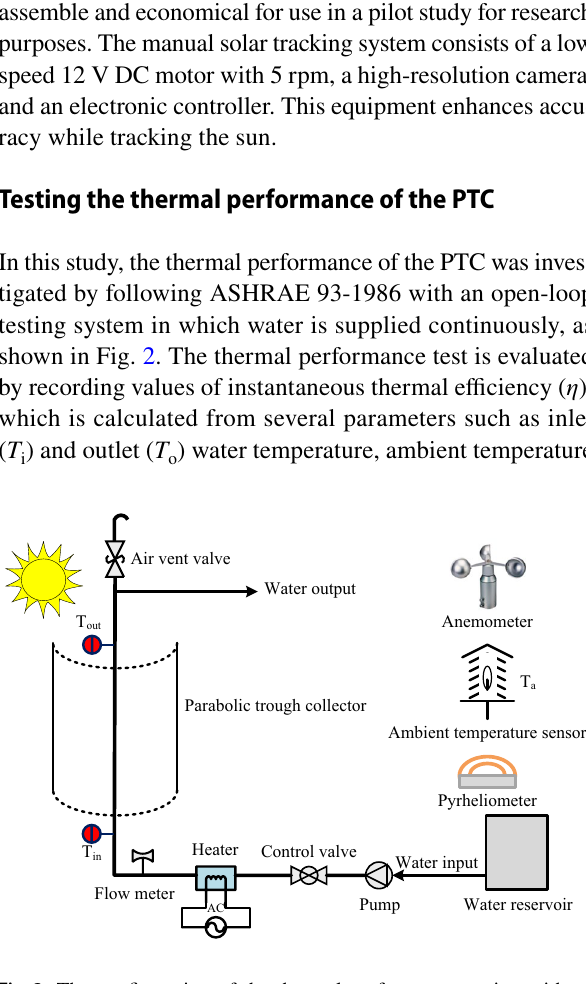
Fig. 2 The configuration of the thermal performance testing with an open-loop system following ASHRAE